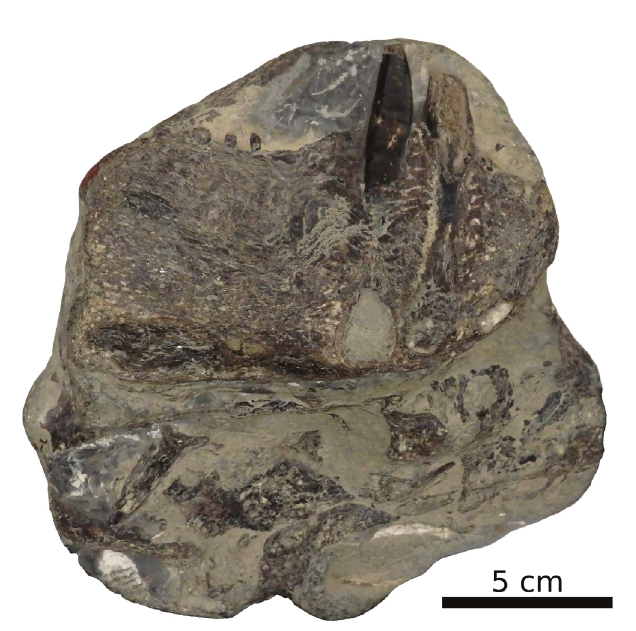
Figure 3. CMN 51273, partial jaws of Xiphactinus audax Leidy 1870, in right lateral